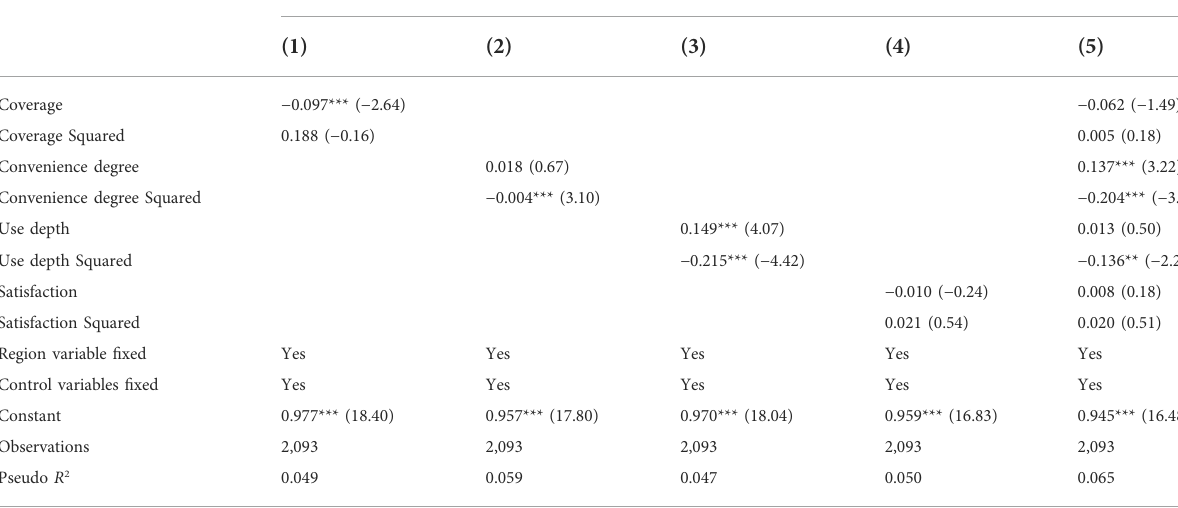
TABLE 6 Model fi tting results of different dimensions of fi nancial inclusion on the economic vulnerability of rural